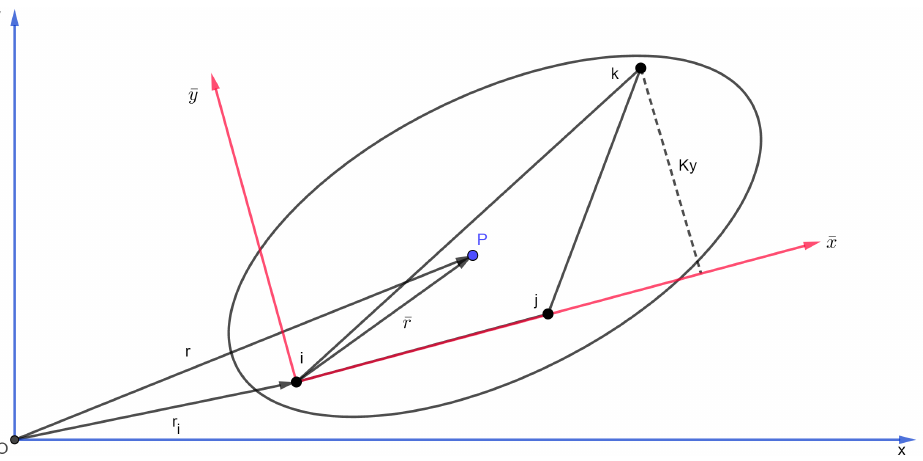
Figure 1. A 2D element with three basic points ( i , j , and k